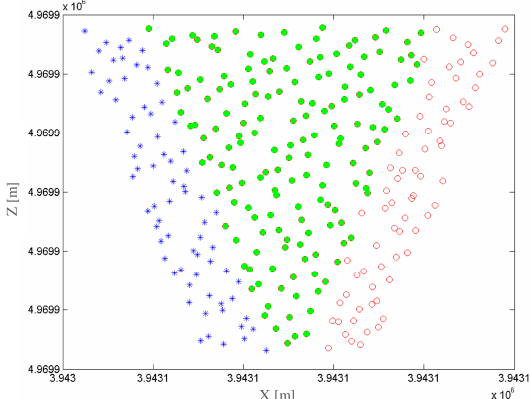
Figure 4. Example of an 80% overlap between two frames, with 150 TP distributed in a quasi-random mode. Blue: object point of frame 1; red: object point of frame 2; green = object point in the overlap area.